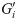
Response comparisons on DSD realized systems under the naive and exact implementations of transfer functions G
1, G
2, and G
3.(A) Responses of G
1 implementations. (B) Responses of G
2 implementations. (C) Responses of G
3 implementations. The curves in red corresponds to naive implementations (under the parameter setting a = 6 in Gi′), while the curves in green correspond to exact implementations.